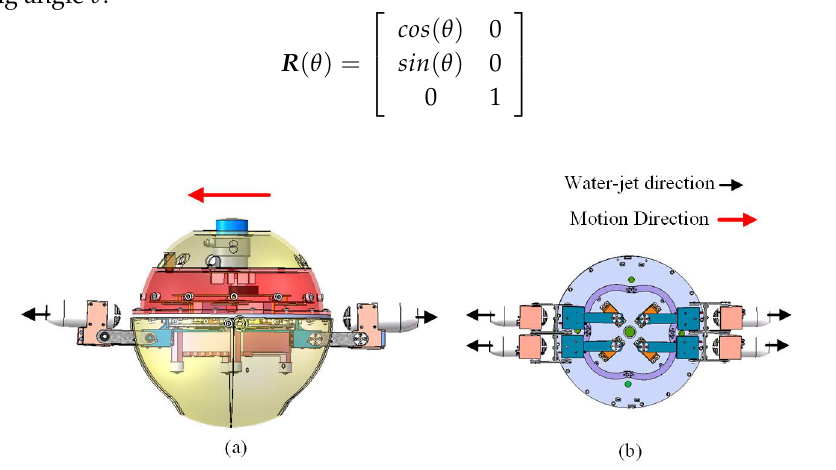
Figure 4. The propulsion distribution in surge motion. ( a ) Front view of the propulsion distribution. ( b ) Upward view of the propulsion